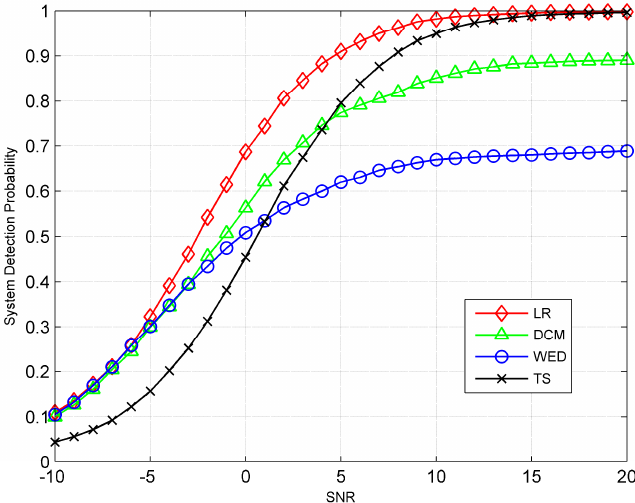
Figure 2. Receiver operating characteristic (ROC) curves for different fusion rules at S = 0 dB.